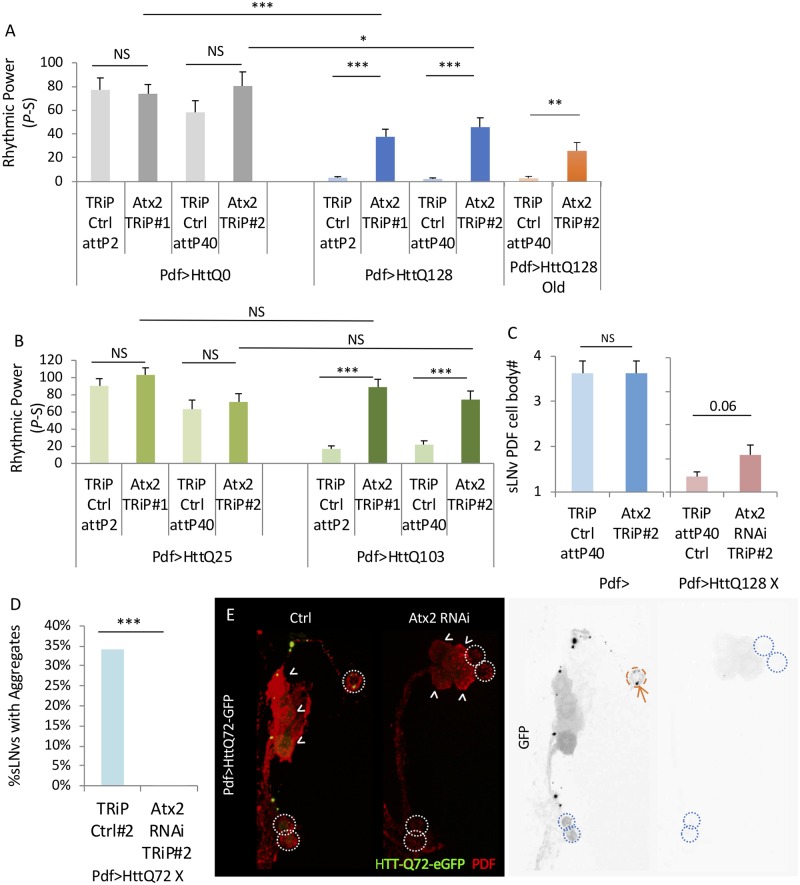
Atx2 partially suppresses mHtt induced circadian arrhythmicity and aggregation.A. Rhythmic power (P-S) is indicated for various genotypes including flies expressing HttQ0 (Pdf>HttQ0 in grey) or HttQ128 (Pdf>HttQ128 in blue) in PDF neurons in a TRiP RNAi library control background (TRiP Ctrl attP2 and attP40) and expressing two independent Atx2 TRiP RNAi lines (Atx2 TRiP #1 and #2; n = 12–41; *p<0.05, **p<0.01, ***:p<0.005, error bars represent standard error). Rhythmic power (P-S) is indicated for aged flies expressing HttQ128 in PDF neurons in a TRiP RNAi library control background (TRiP Ctrl attP40) or expressing Atx2 TRiP RNAi (Atx2 TRiP #2, in orange). Flies were at the age of day 9–17 during DD behavior. B. Rhythmic power (P-S) is indicated for various genotypes including flies expressing HttQ25 or HttQ103 in PDF neurons (Pdf>HttQ25 or Pdf>HttQ103 in green) in PDF neurons in a TRiP RNAi library control background (TRiP Ctrl attP2 and attP40) and expressing two independent Atx2 TRiP RNAi lines (Atx2 TRiP #1 and #2; n = 18–42; *p<0.05, **p<0.01, ***:p<0.005, error bars represent standard error). C. The number of sLNv PDF cell bodies per brain hemisphere at age day 10 is indicated for various genotypes where either Atx2 RNAi (Atx2 TRiP#2) or TRiP RNAi library control (TRiP Ctrl attP40) together without (n = 4–6) or with HttQ128 are expressed is shown (n = 19–26; *p<0.05 **p<0.01, ***:p<0.005, error bars represent standard error). D. Percentage of sLNvs (labeled with PDF in red) at age day 7 containing HttQ72-eGFP aggregates (in green) in a TRiP RNAi library control background (TRiP Ctrl attP40) and expressing a Atx2 TRiP RNAi lines (Atx2 RNAi TRiP #2) is quantified (n = 27–41; *p<0.05, **p<0.01, ***:p<0.005). E. Representative images of sLNv and lLNv for corresponding genotypes in D are shown. White arrowheads indicate lLNvs. White dot circles label sLNvs in the merged figure. Orange dash circles label sLNvs with aggregates while blue dot circles label sLNvs without aggregates in the grey scale of the green channel. Example aggregates are pointed out by orange arrows.